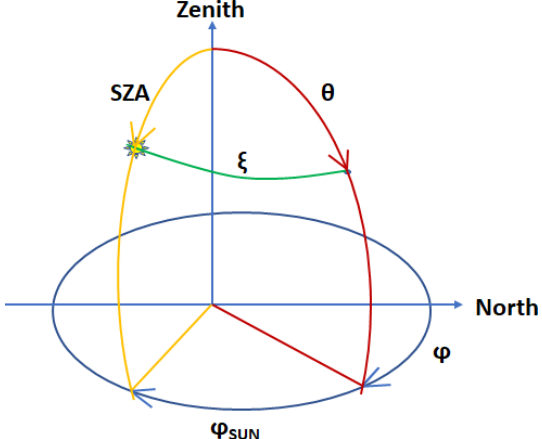
Figure 3. Geometry of the problem. The Sun is located at the coor- dinates (SZA, ϕ SUN ) and the sky point is in θ , φ . The instrument is located at the origin of the